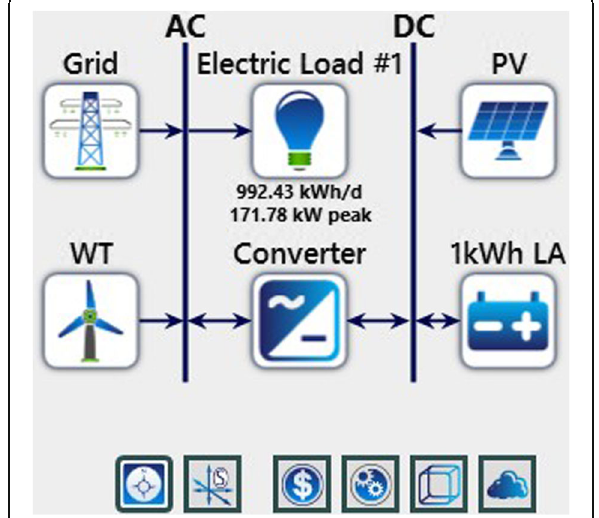
Fig. 8 HOMER ® simulation model for case